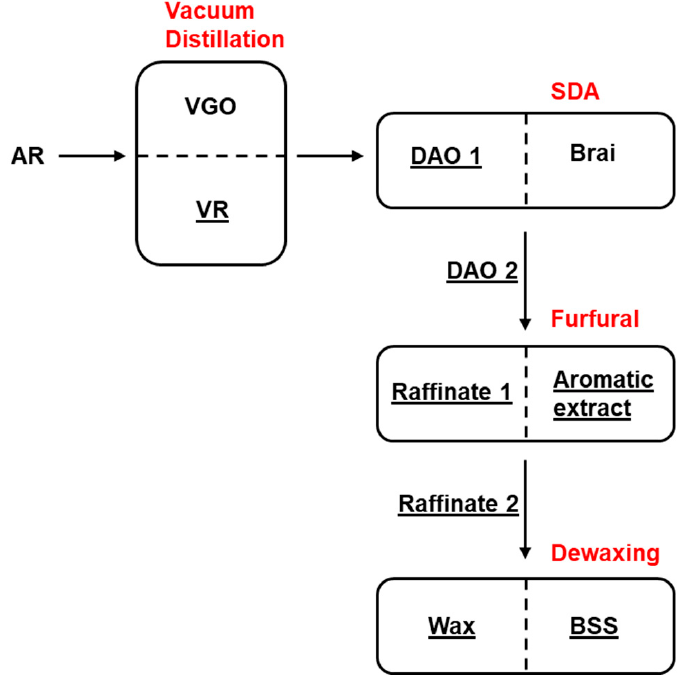
Figure 1. Lubricant oil production scheme.